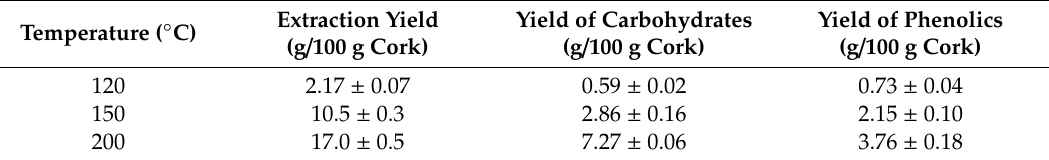
Table 2. E ff ect of temperature on the SBW extraction / hydrolysis of granulated